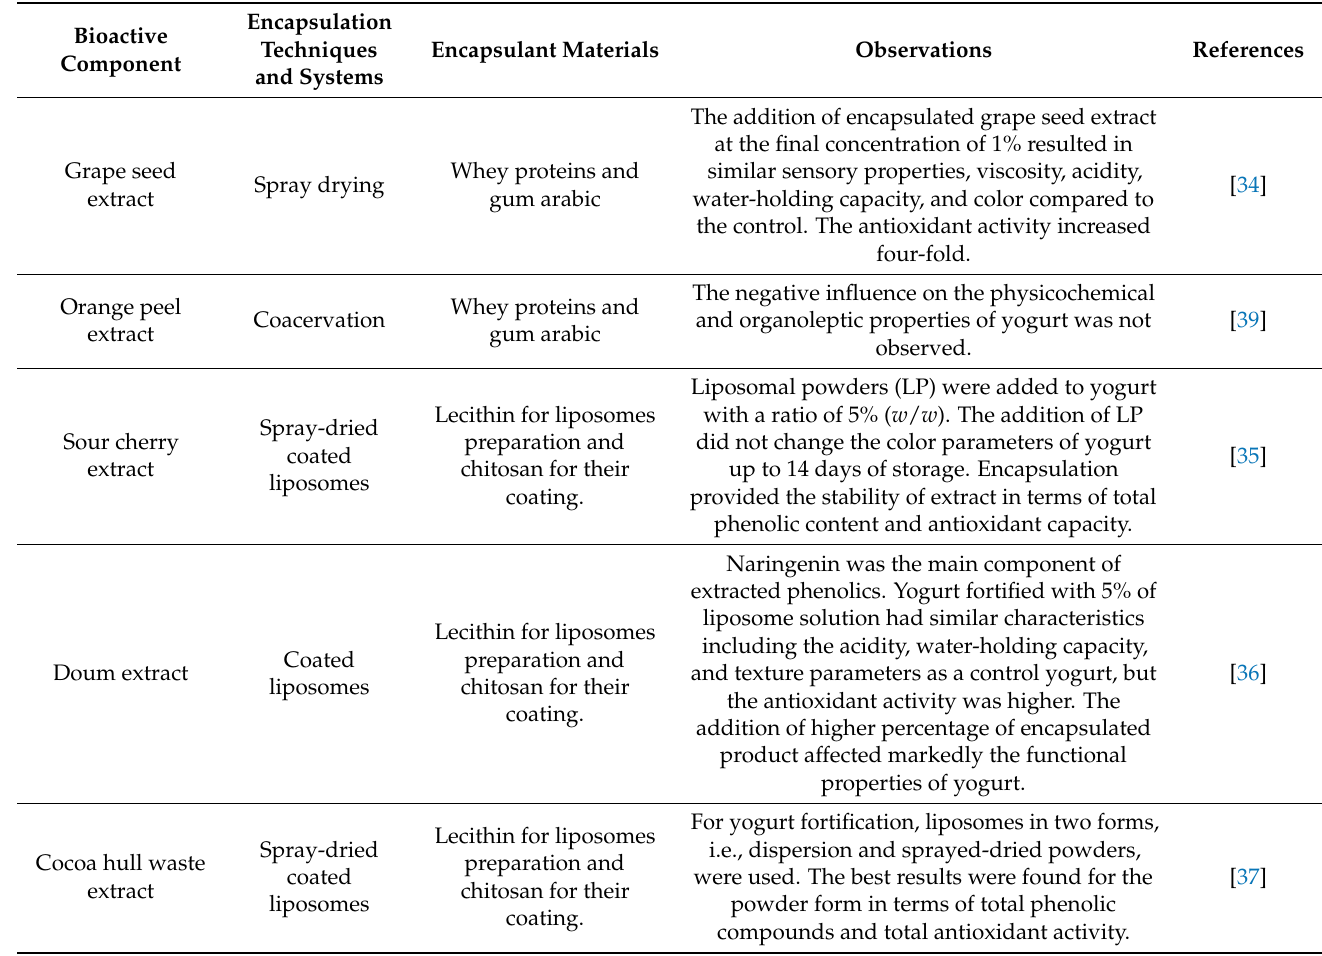
Table 2. Encapsulation of phenolic compounds containing components for yogurt’s